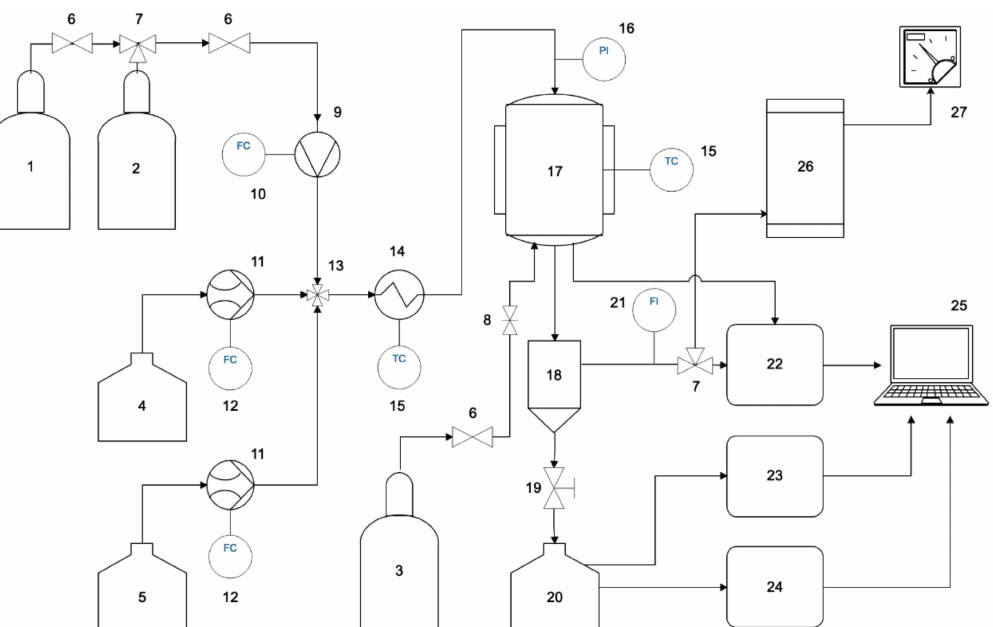
Figure 2. Design of the laboratory setup for the dehydrogenation of ethylbenzene to styrene. Designa- tions: (1) argon gas cylinder for purging the reactor; (2) raw gas mixture cylinder; (3) gas cylinder with argon carrier gas for purging the hydrogen-selective membrane; (4) container with liquid substrate; (5) container with distilled water; (6) gas reducer; (7) three-way valve; (8) fine adjustment valve for the argon carrier gas flow rate; (9) gas flow regulator valve; (10) gas flow controller; (11) liquid pump; (12) liquid pump flow controller; (13) mixing valve for gas–liquid flows; (14) evaporator; (15) temperature processor; (16) pressure sensor; (17) electrically heated catalytic membrane reactor; (18) liquid separator; (19) shut-off valve; (20) liquid receiver; (21) gas flow indicator; (22) gas chromato- graph; (23) gas chromatograph/mass spectrometer; (24) gas liquid chromatograph; (25) computing workstation for data processing; (26) SOFC; (27) SOFC instrumentation and controls.